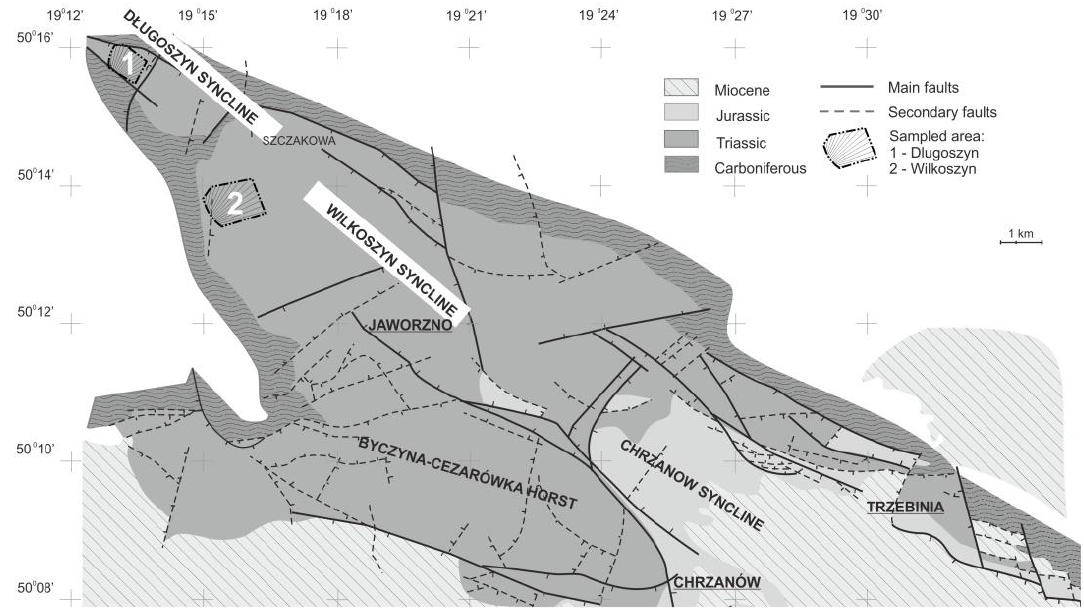
Figure 2. Geological context of the study area, without Quaternary sediments (after Figure 1. Geological context of the study area, without Quaternary sediments (after [54]).